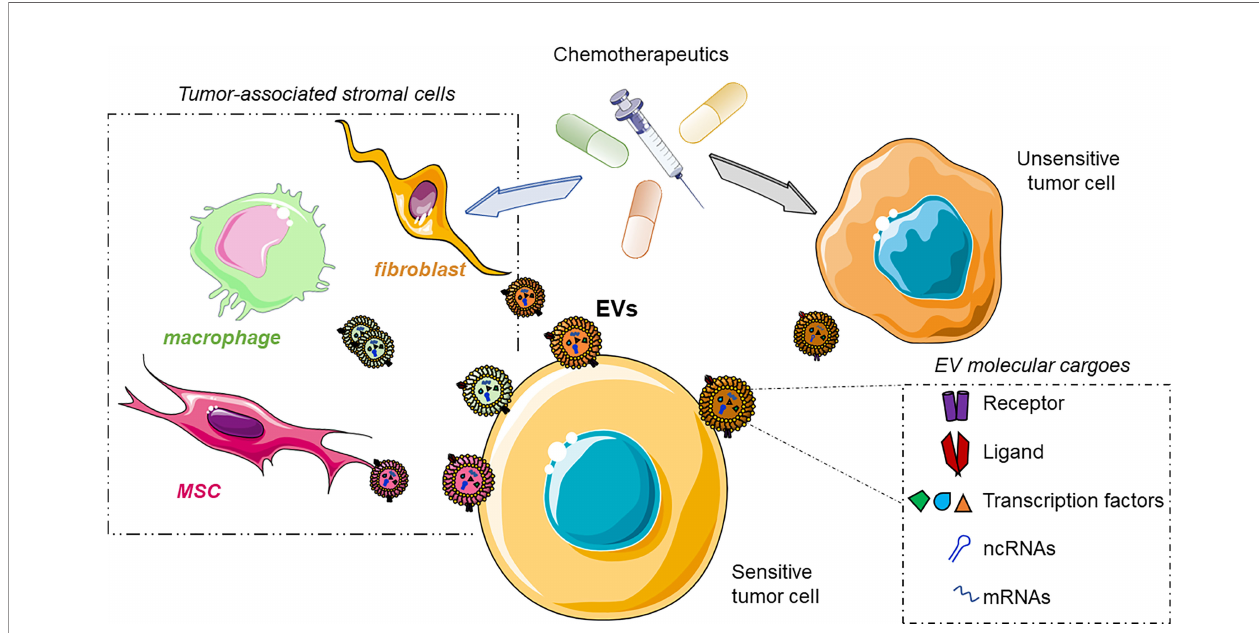
FIGURE 3 | Cartoon illustrating the involvement of EVs in the spreading of chemoresistance among the cells of the tumor microenvironment (TME). The drugs induce the modi fi cation of the gene expression of primary tumor cells or TME cells. These cells release EVs enriched in the molecular players involved in the acquisition of drug resistance in the EV-donor cells, fi nally taken up by the sensitive tumor cells acquiring the insensitiveness toward the chemotherapeutic. Bottom- right box: molecular effectors involved in drug resistance shuttled through the EVs. ncRNAs, non-coding RNAs; mRNAs, messenger RNAs. This fi gure was drawn with the support of the bioicons